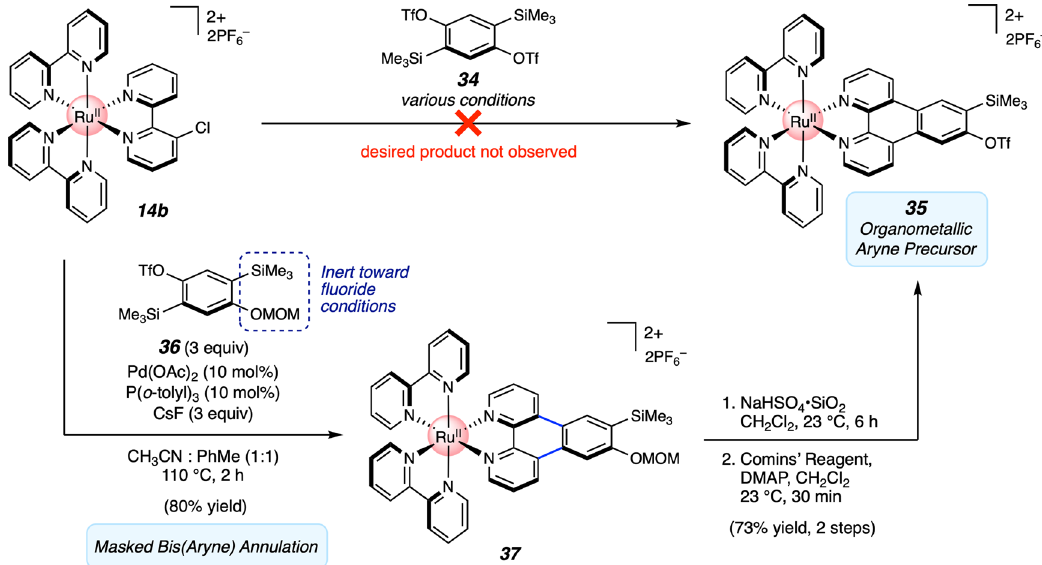
Fig. 7 Synthesis of an organometallic aryne precursor via masked bis(aryne) annulation. OTf, tri fl uoromethanesulfonate; MOM, methoxymethyl; DMAP,